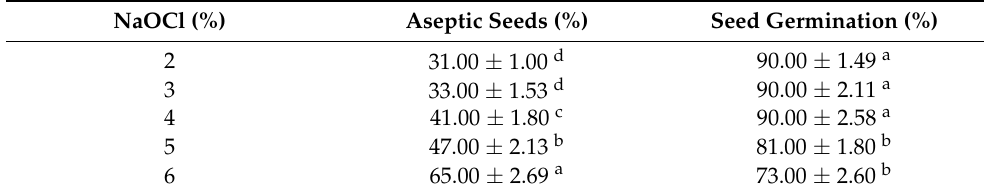
Table 1. Effects of NaOCl concentrations on aseptic seeds and seed germination of the feverfew plant. NaOCl (%) Aseptic Seeds (%) Seed Germination